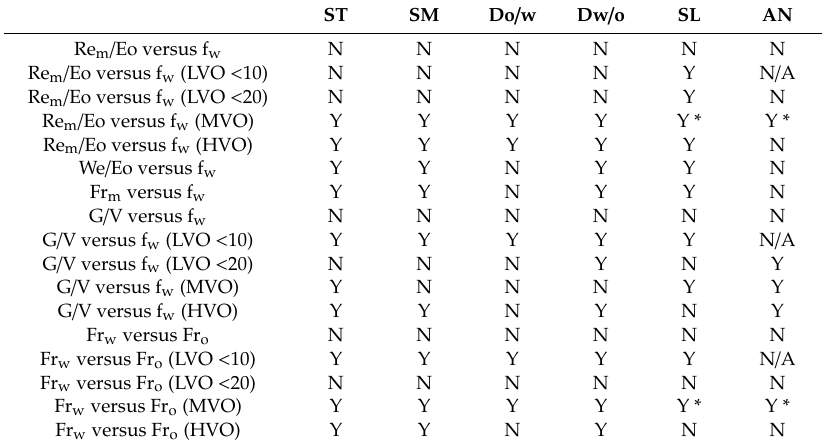
Table 5. A summary of constructed flow pattern maps using dimensionless parameters.